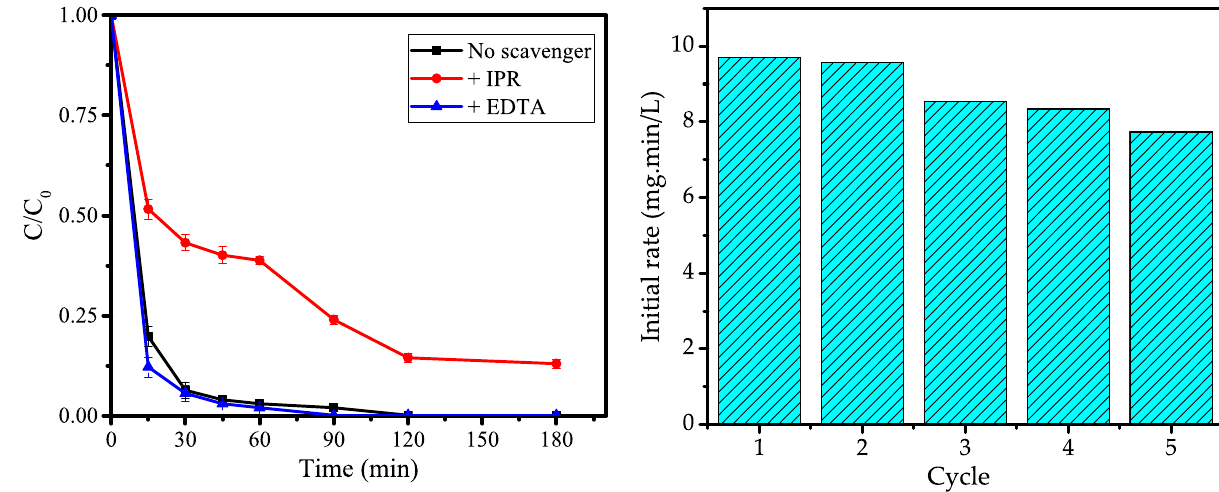
Figure 14: The kinetics of PCPO in the presence and absence of the scavengers.